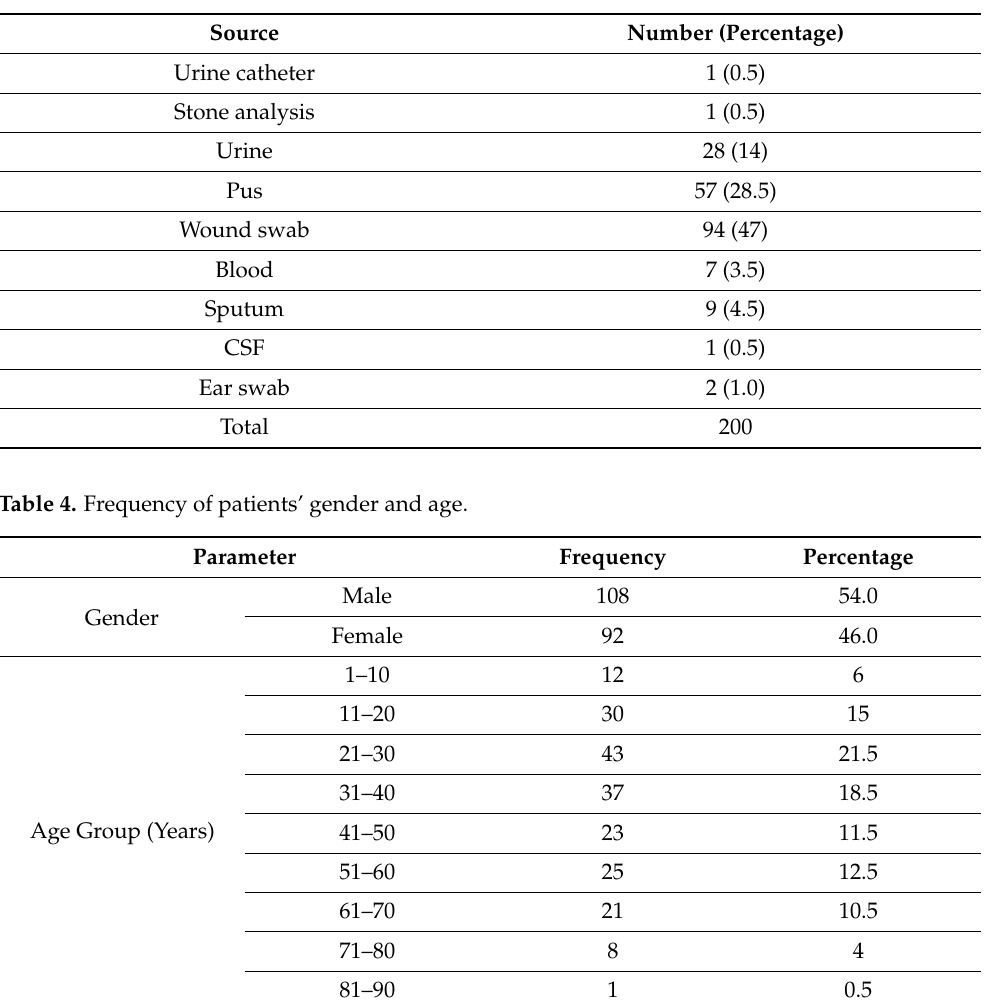
Table 3. Collection of clinical samples of P. aeruginosa from various sources.